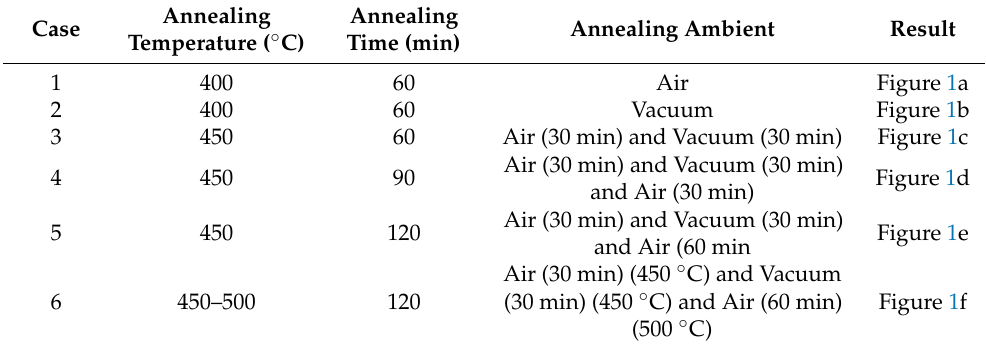
Table 1. Pre-sintering Cases.